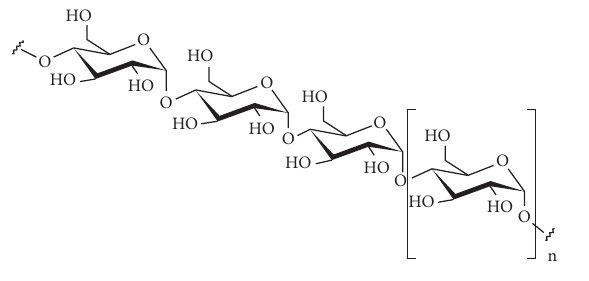
Figure 1: Molecular structure of amylose.